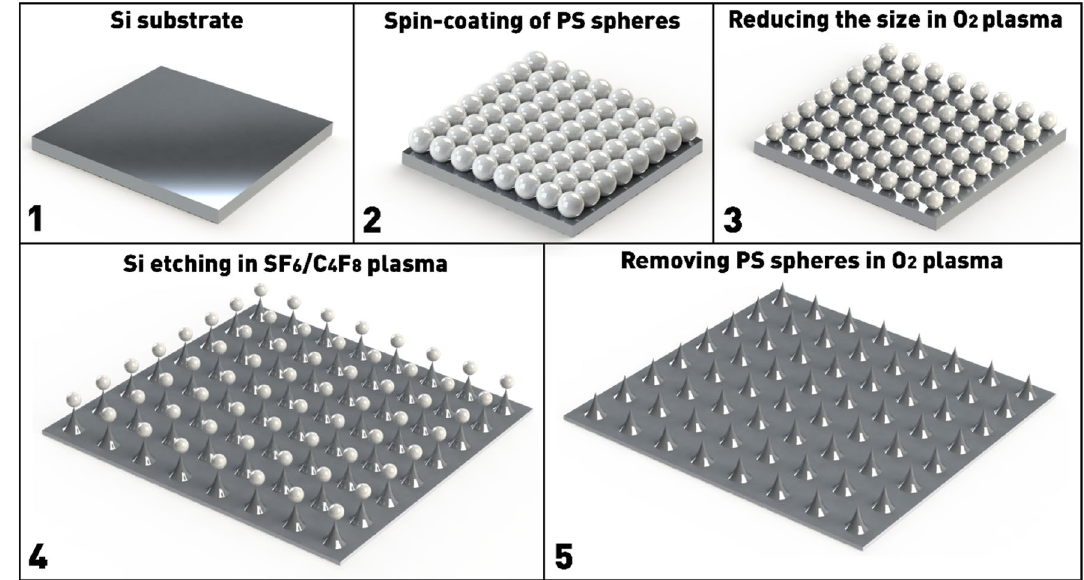
Figure 1. Schematic image of the basic steps for creating ordered silicon nanostructures through a mask of polystyrene